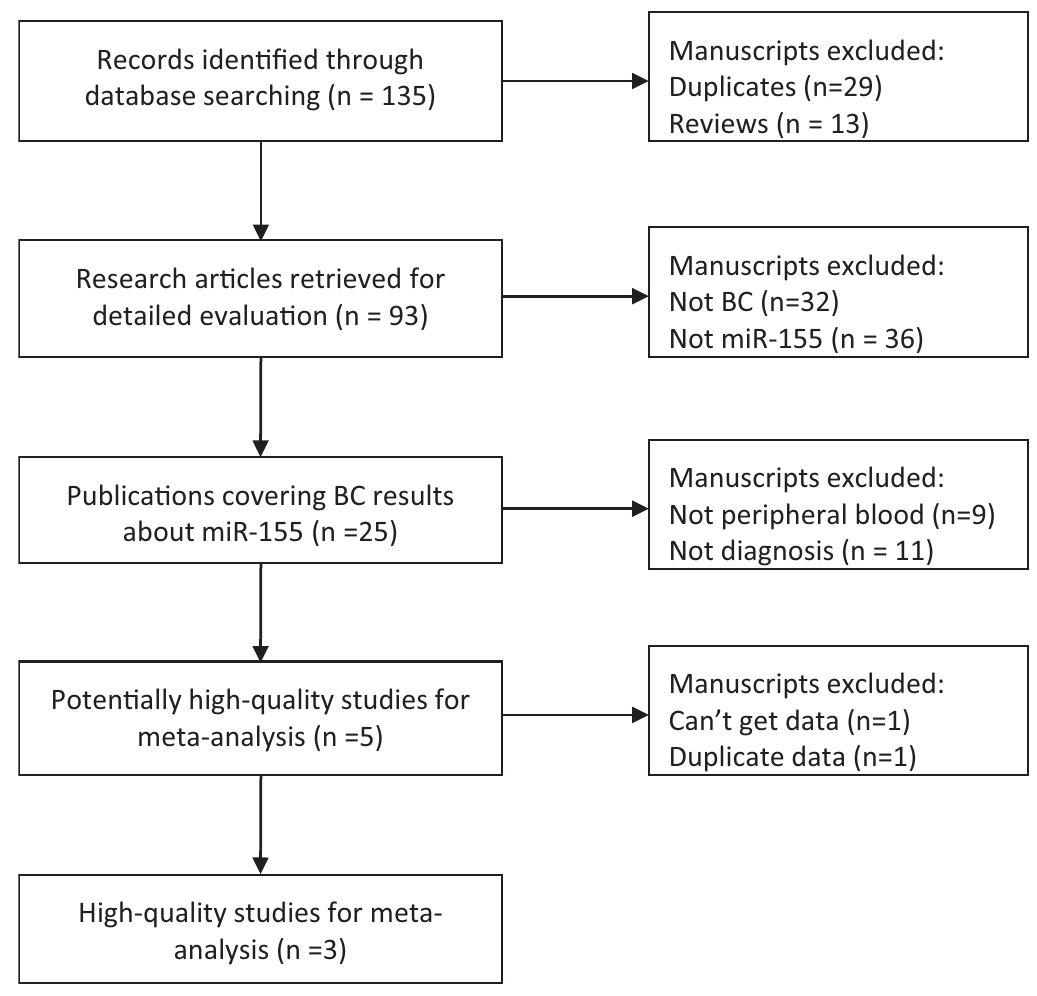
Figure 1. Flow diagram for studies retrieved through the searching and selection